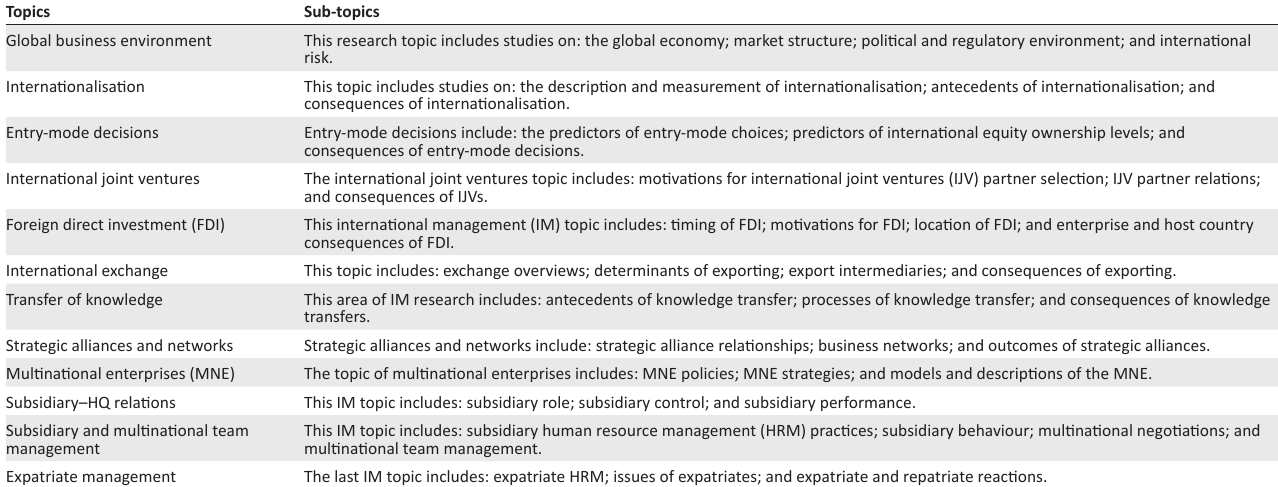
TABLE 1: International management classification